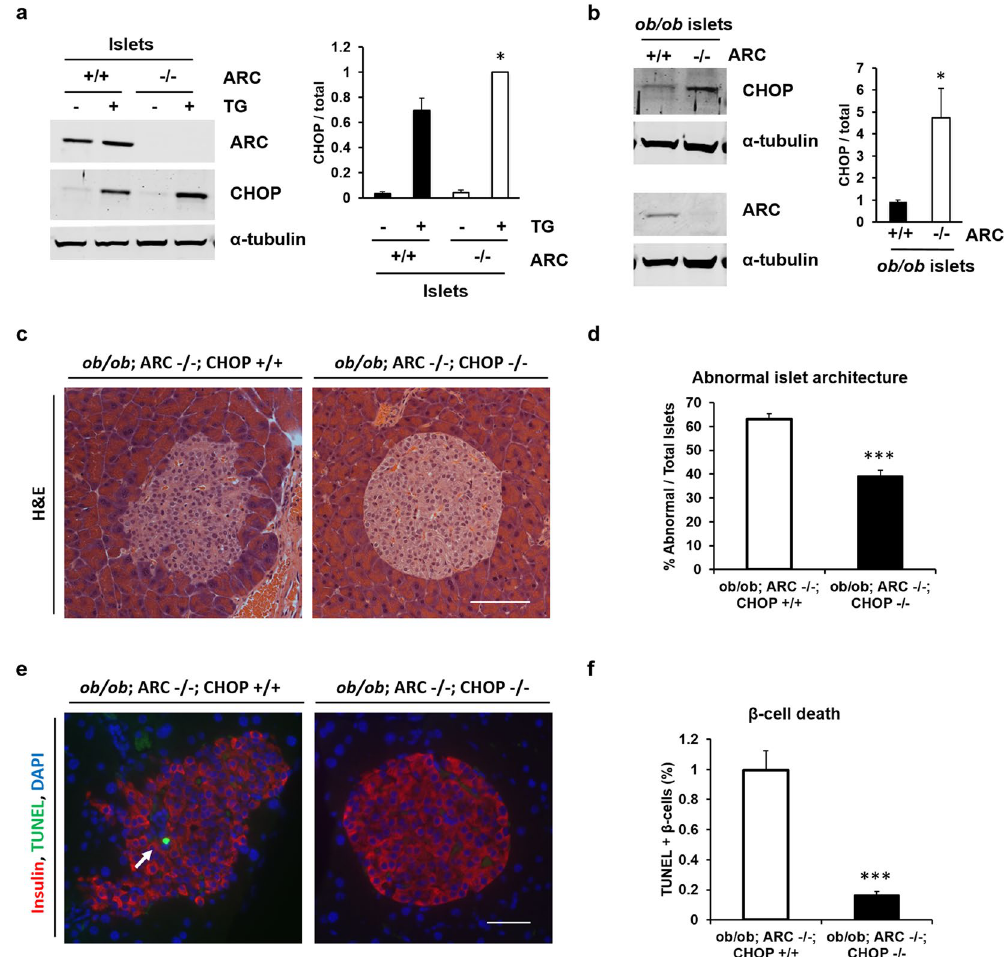
Figure 4. Deletion of CHOP restores islet architecture and β -cell viability in ob/ob ; ARC − / − mice. ( a ) Immunoblot (left) and quantification (right) of islets isolated from indicated mice and treated overnight with ER stressor thapsigargin (TG, 1 μ M). Graph is average of three independent experiments. ( b ) Immunoblot (left) and quantification (right) of islets isolated from ob/ob ; ARC + / + and ob/ob ; ARC − / − mice. Graph is average of three samples for each genotype. ( c ) Pancreatic tissue from 24 wk old mouse stained with Hematoxylin and eosin (H&E). ( d ) Percentage of abnormal islets as determined from H&E staining. ( e ) β -cell apoptosis as determined by TUNEL (green) and insulin (red) staining. Arrow indicates TUNEL-positive β -cell. ( f ) Quantification of TUNEL staining. Scale bar 100 μ M. *** P <